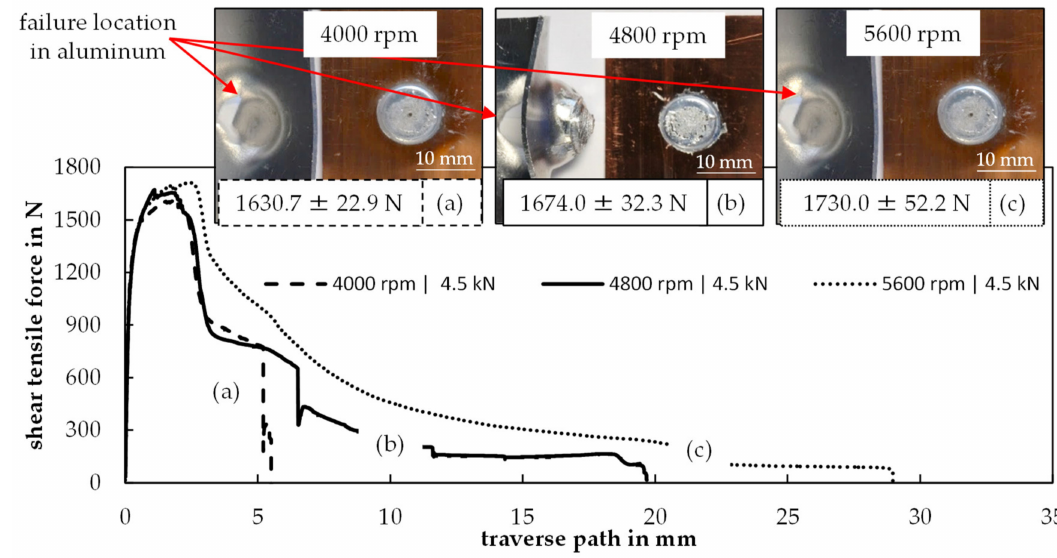
Figure 12. Influence of rotational speed on the force-path curves and failure patterns of the welded samples.